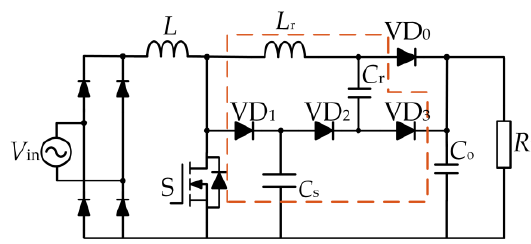
Figure 1. Lossless snubber Boost PFC circuit topology.